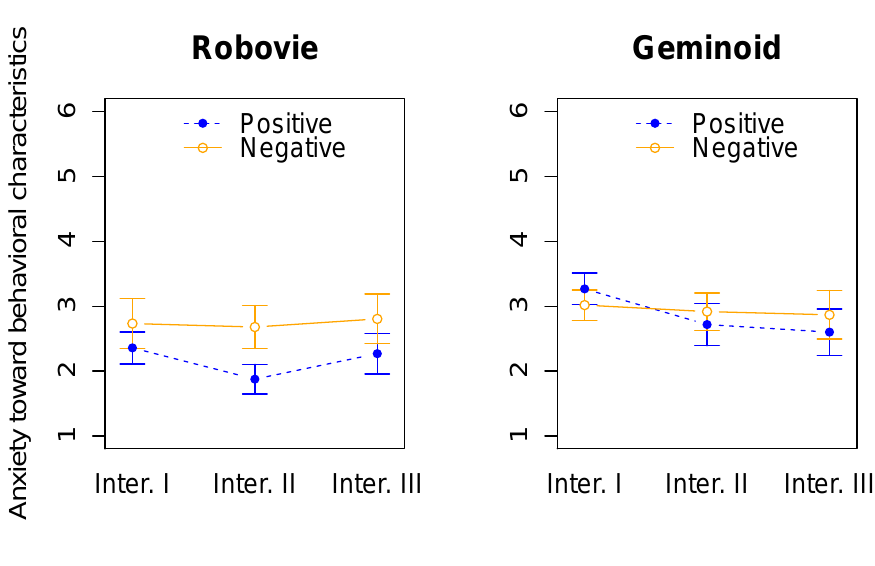
Figure 7: Mean anxiety toward behavioral characteristics with 95% confidence intervals measured in each interaction round (Interaction I, II and III) for positive and negative behaviour of both robots. Higher scores indicate higher anxiety toward behavioral characteristics a